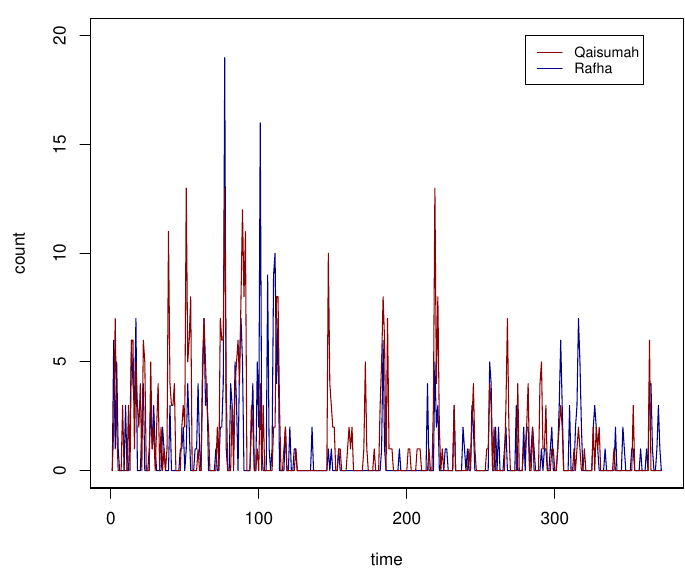
Figure 3. Sandstorm counts of Rafha and